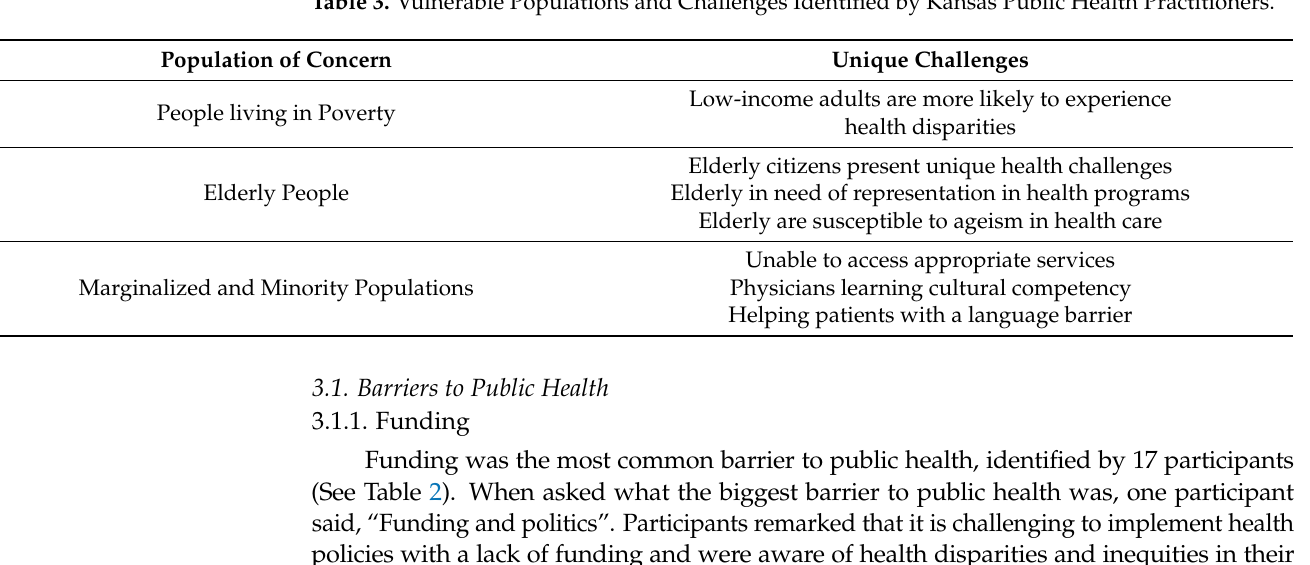
Table 3. Vulnerable Populations and Challenges Identified by Kansas Public Health